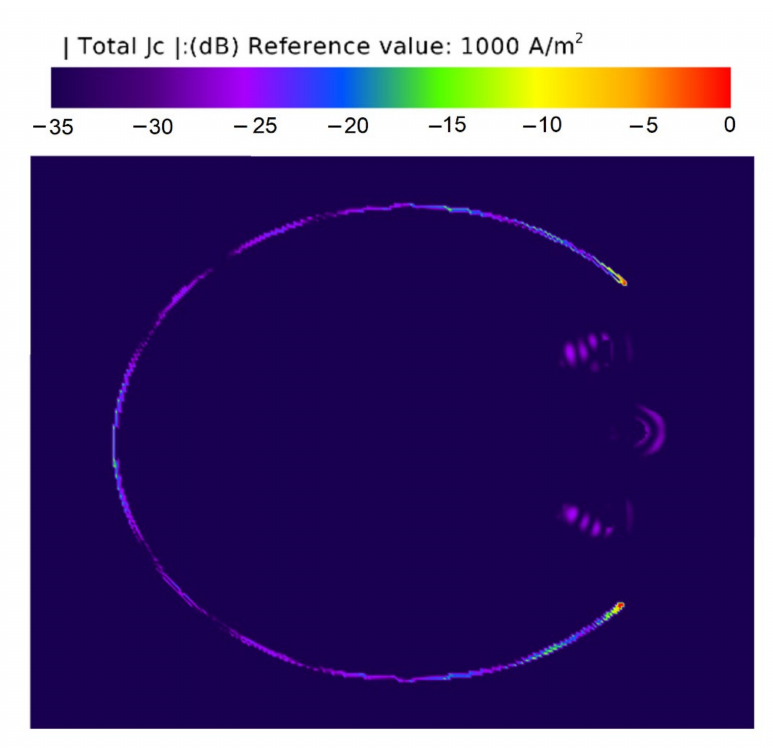
Figure 18. Current distribution for 3600 MHz.